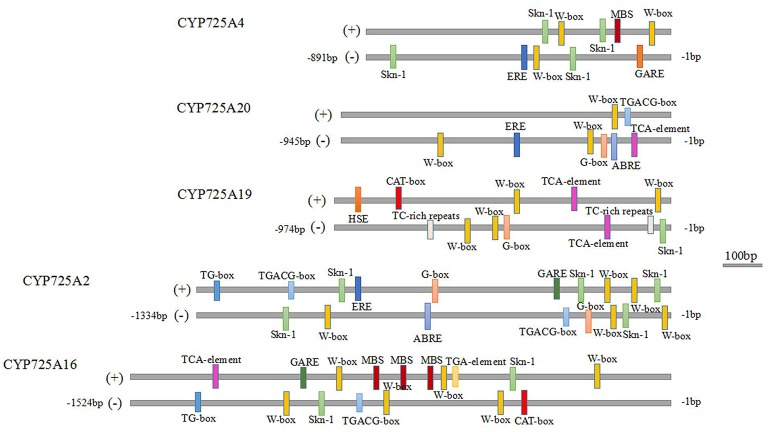
Cis-acting elements in the promoter regions of CYP725 genes. The scale bar represents 100 bp.